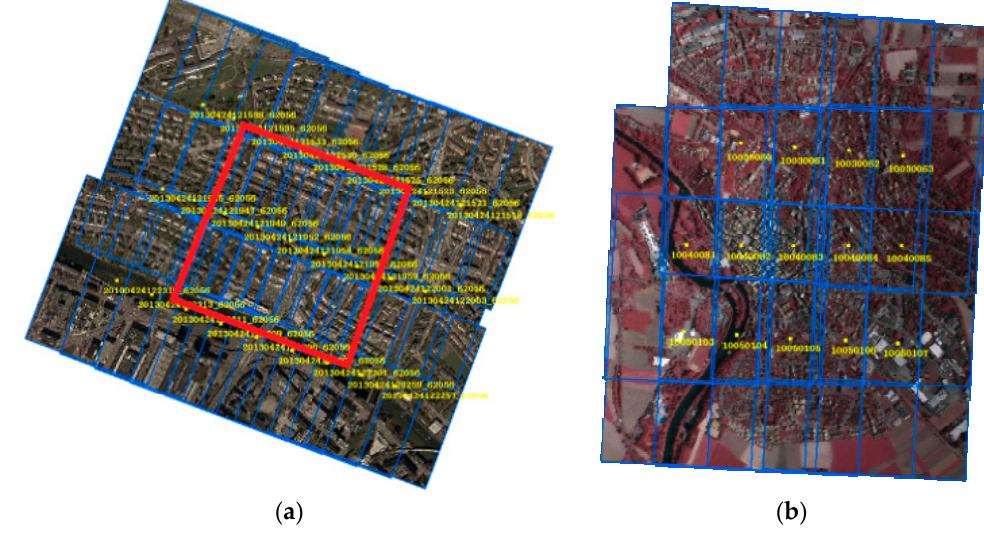
Figure 6. The coverage and overlap relationships of test image datasets: ( a ) Zürich dataset (red rectangle for test area); ( b ) Vaihingen dataset.